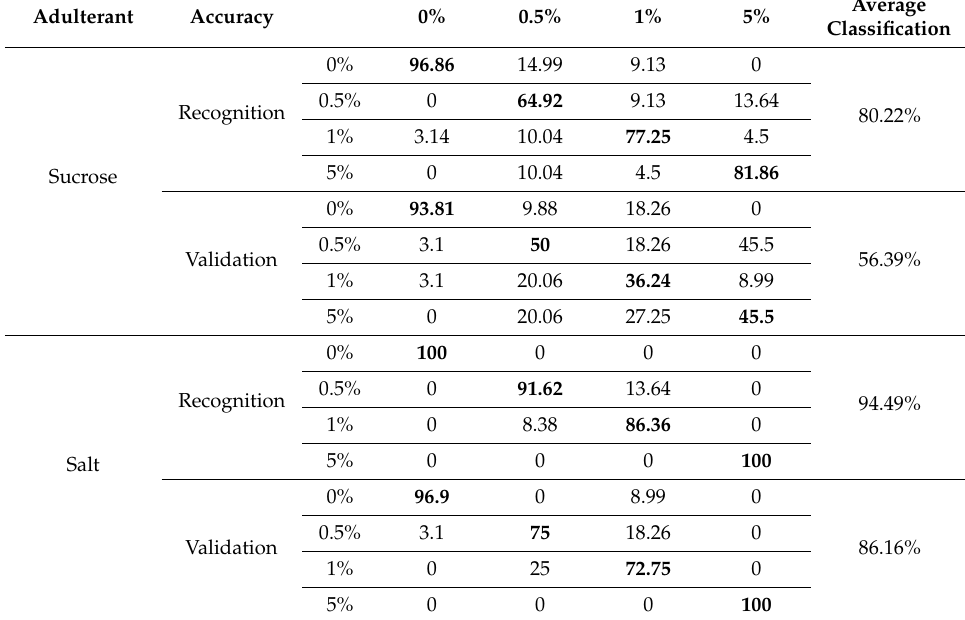
Table 11. LDA classifications after drift correction, outlier detection and three-fold cross-validation when the adulterant concentration was used as class variable on the e-tongue data of sucrose—and salt—adulterated tomato